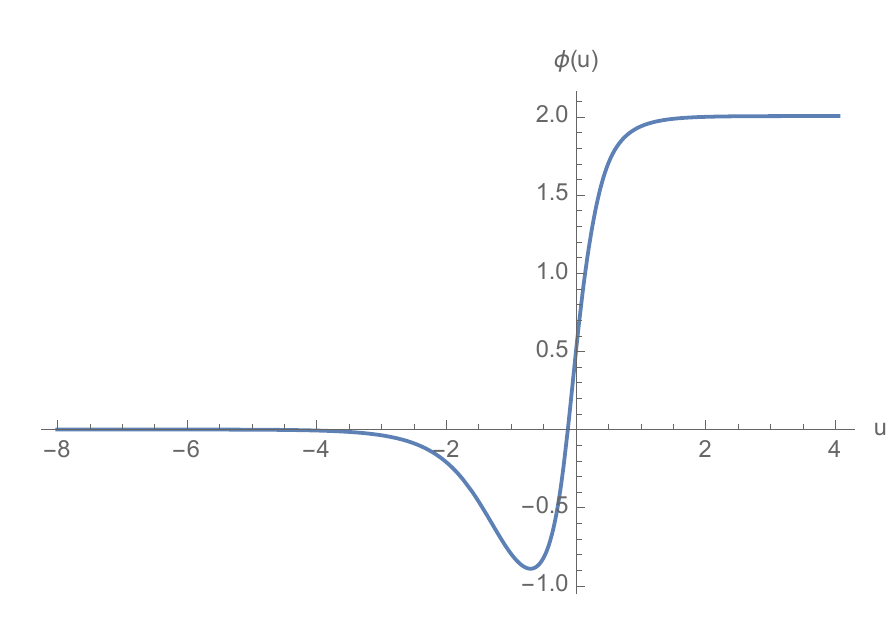
Figure 18 . Example of a dilaton potential that leads to bouncing solutions. The potential is as in equation (4.2) with a choice of parameters d = 4, (cid:1) (cid:0) = 1 : 7, (cid:30) 0 = 4, (cid:0) = 2 = The UV (cid:12)xed point corresponds to (cid:30) = 0 and the IR (cid:12)xed point corresponds to (cid:30) (cid:25) 2 : 00566.